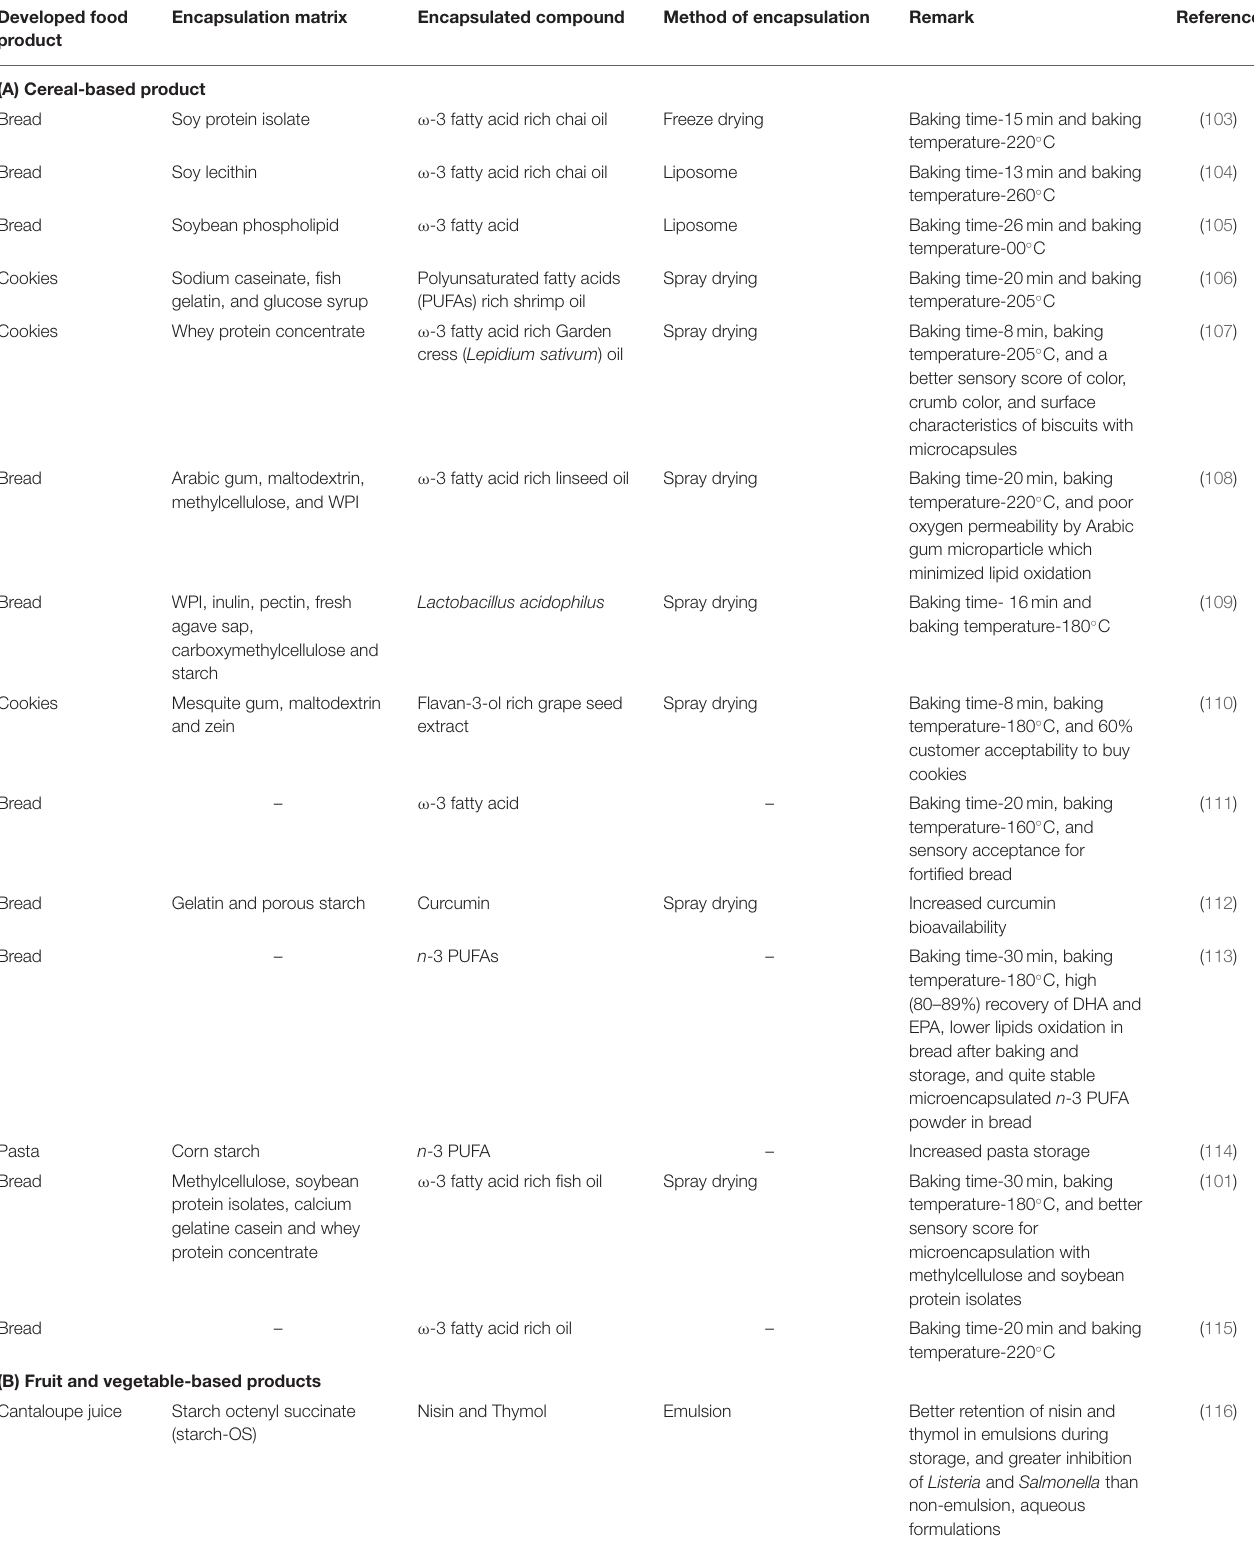
TABLE 3 | Food product developed by the encapsulation of bioactive compounds (BACs) containing immunological